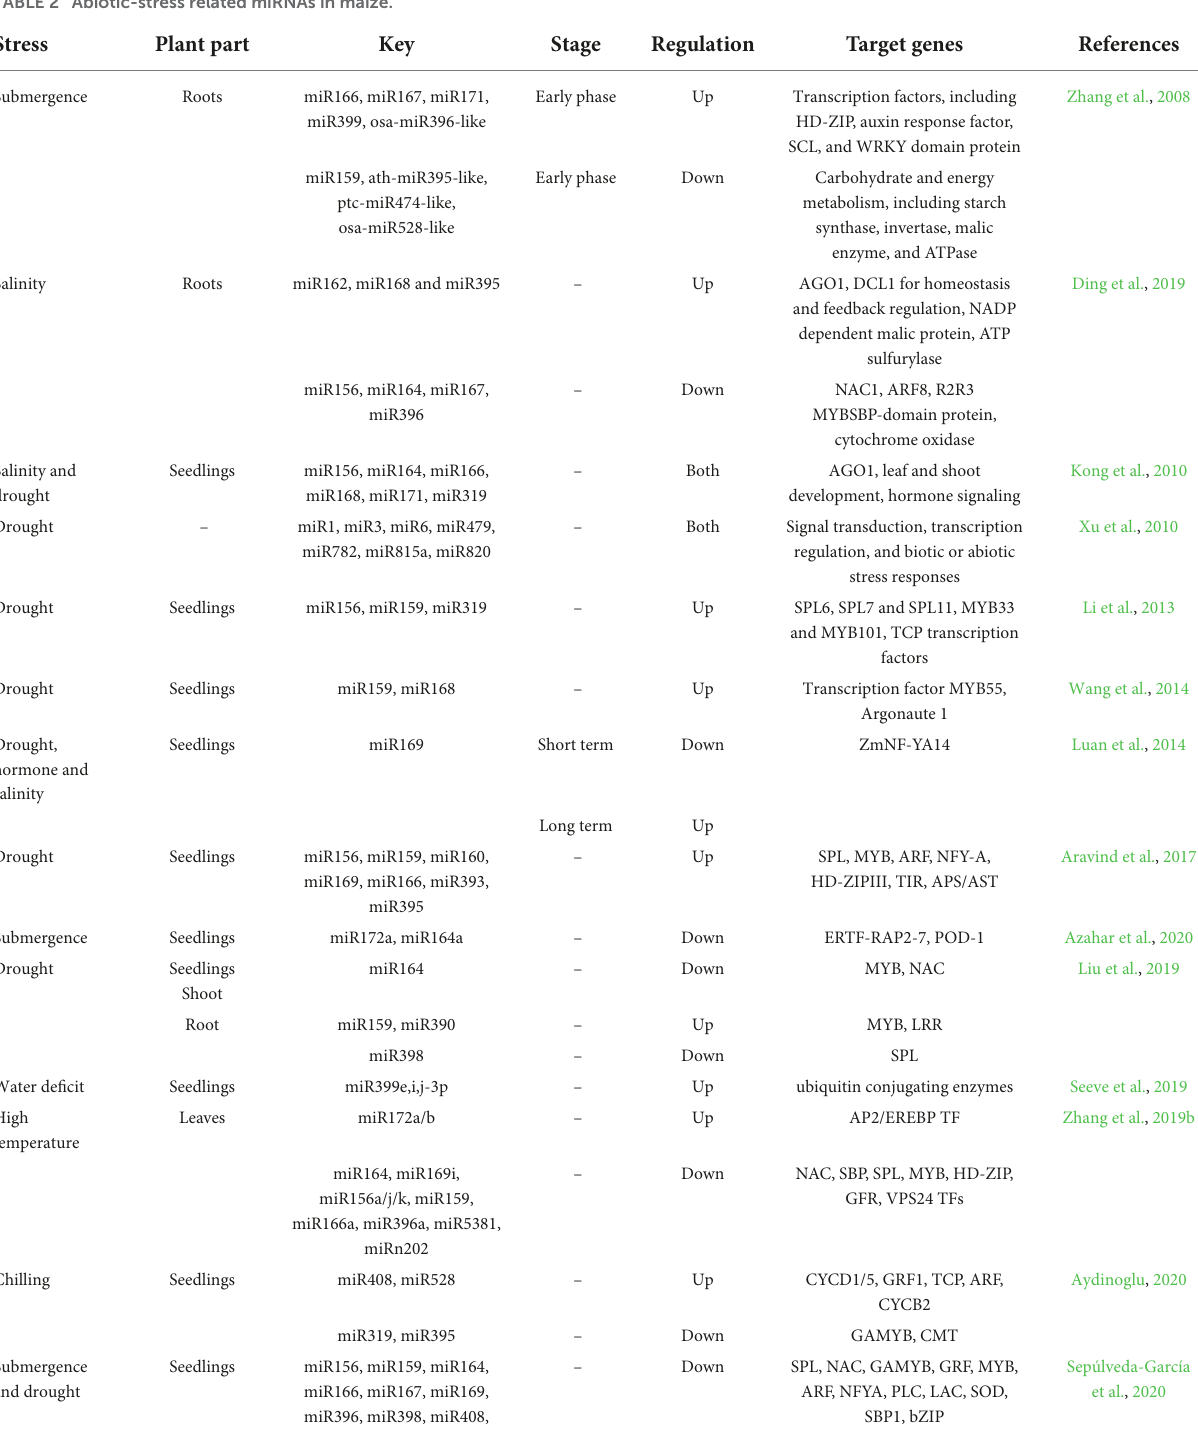
TABLE 2 Abiotic-stress related miRNAs in